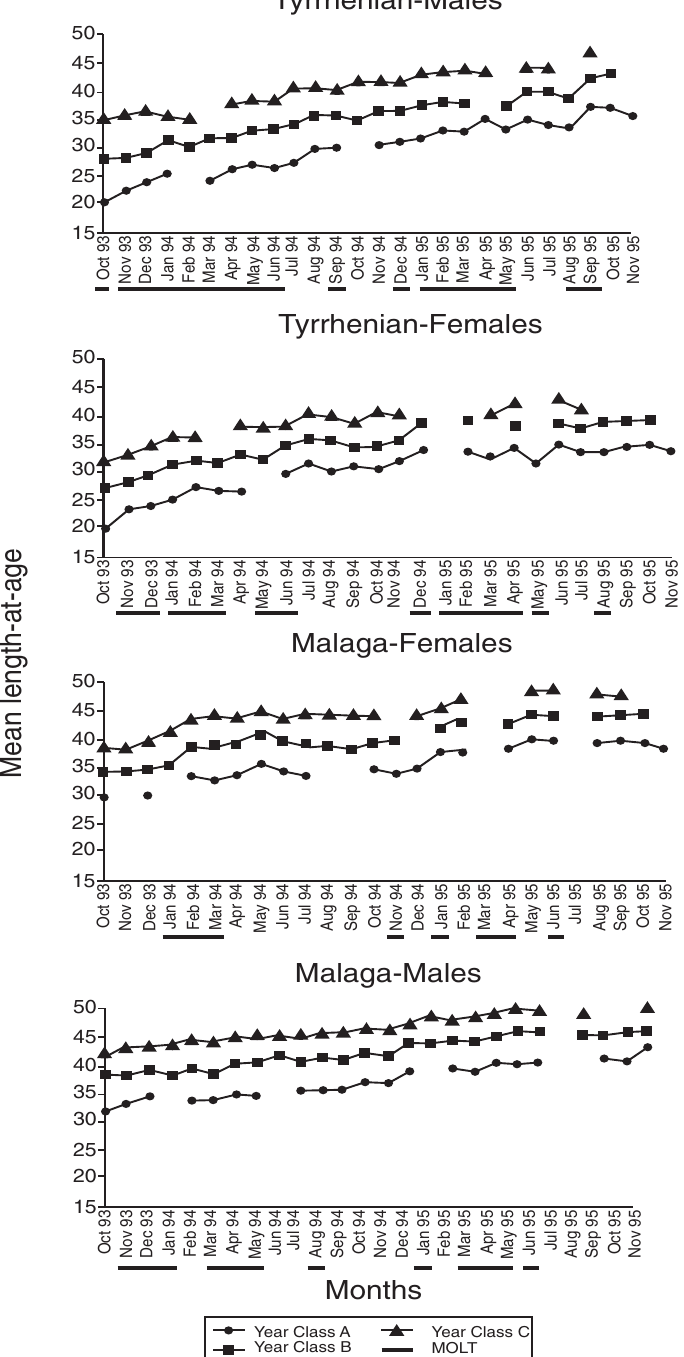
F IG . 3. – Examples of the continuity of modes over time for three year classes (the most representative in the samples). Increase in length is observed after moulting, and is more easily detected in adult females (restricted moulting period) than in males (moulting all the